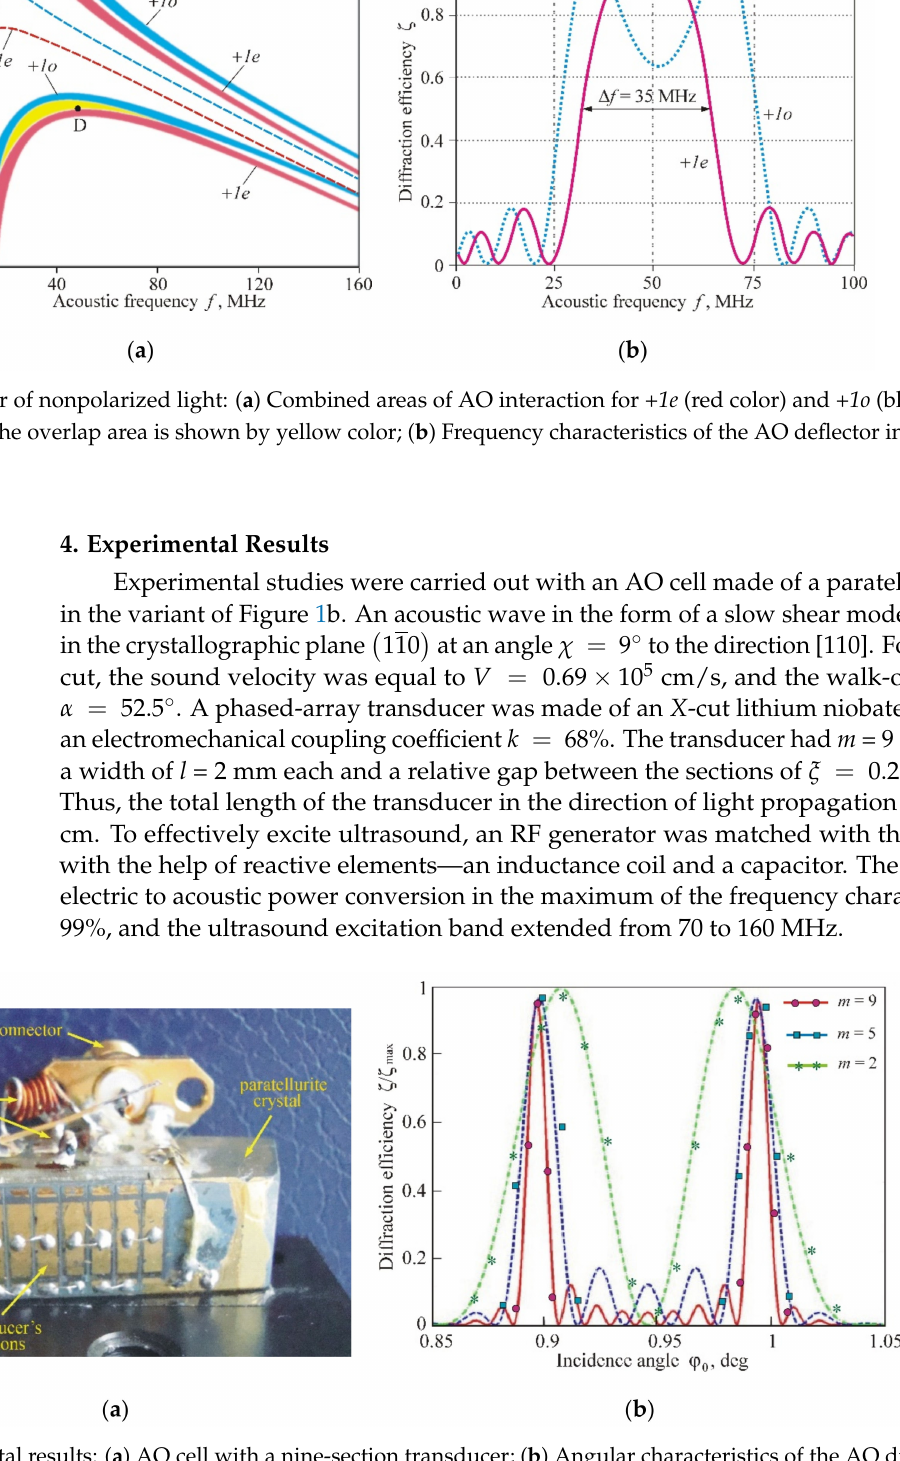
Figure 10. Experimental results: ( a ) AO cell with a nine-section transducer; ( b ) Angular characteristics of the AO diffraction for different number of connected sections: m = 9 (red), 5 (blue) and 2